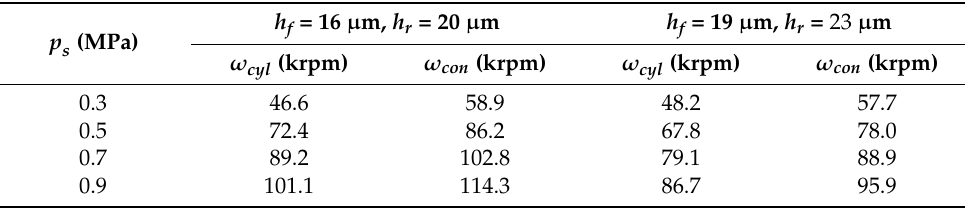
Table 9. Undamped natural frequencies at different supply pressures and radial clearances.